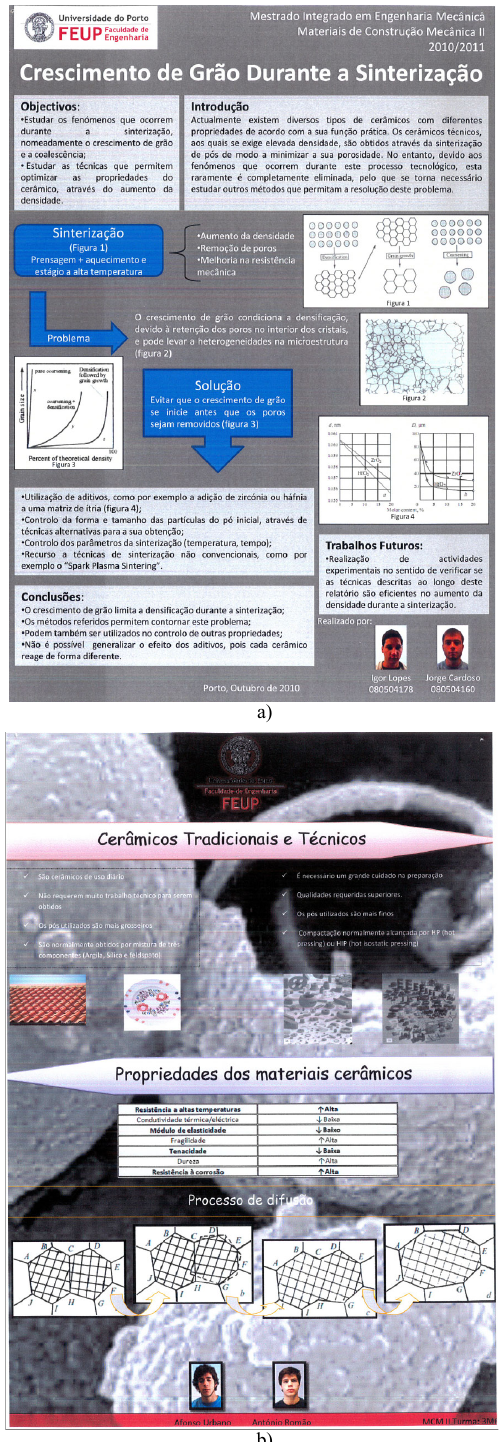
Figure 2. Posters of the work; a) poster with a good grade and b) poster with lower final grade. 7. In the specific case of the paper “Particulars of the Technology of High-Density Technical